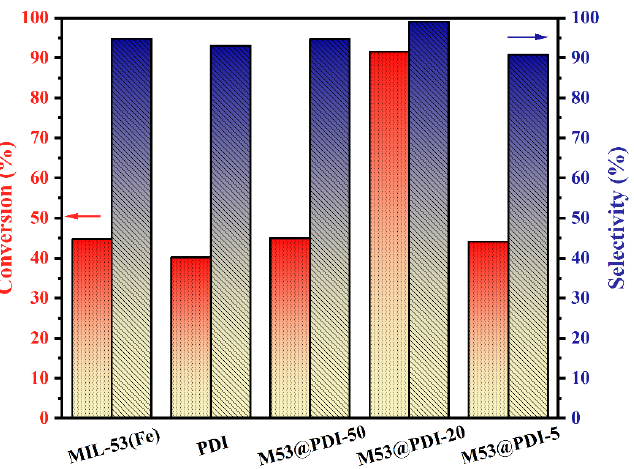
Figure 6. Selective oxidation of benzyl alcohol over PDI, MIL-53(Fe), and MIL-53(Fe)@PDI hetero- junctions under visible light irradiation.